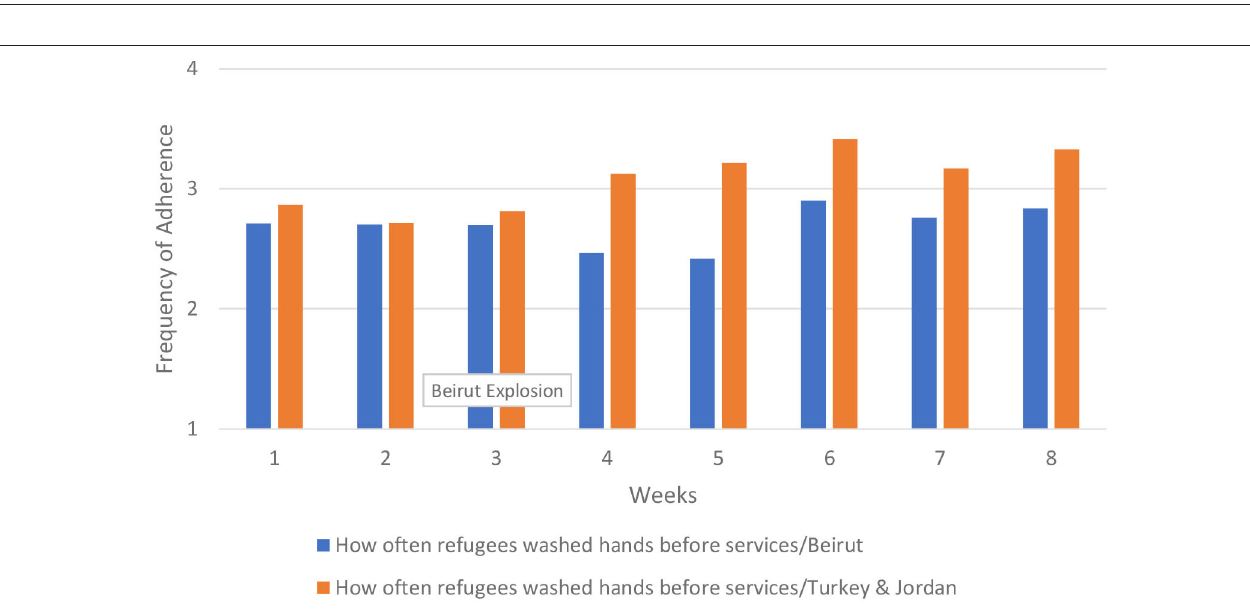
FIGURE 10 | How often refugees used hand sanitizer before